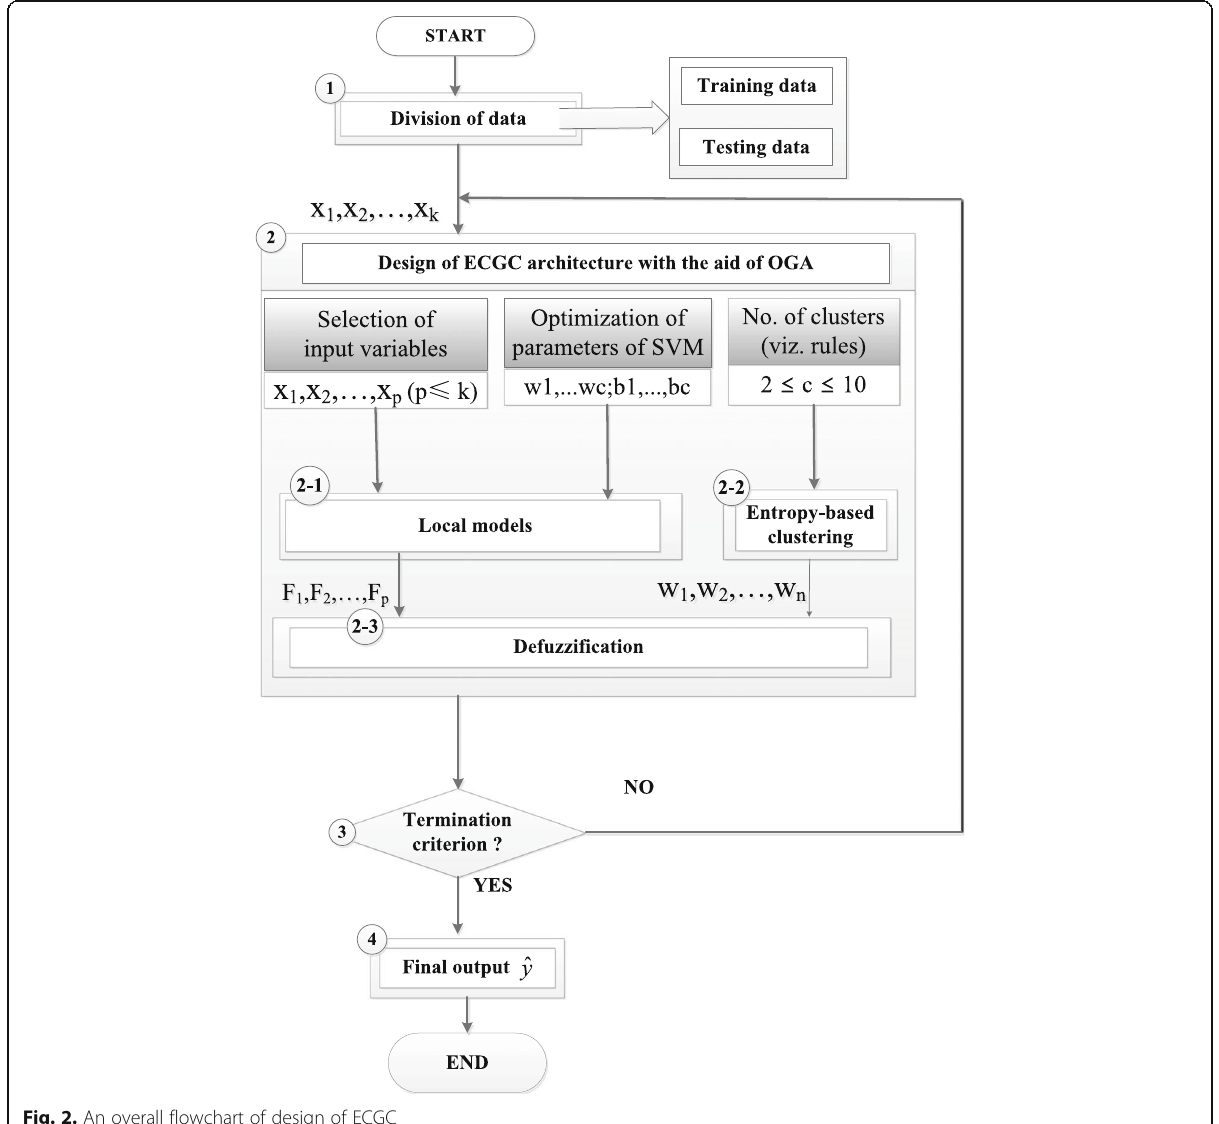
Fig. 2. An overall flowchart of design of